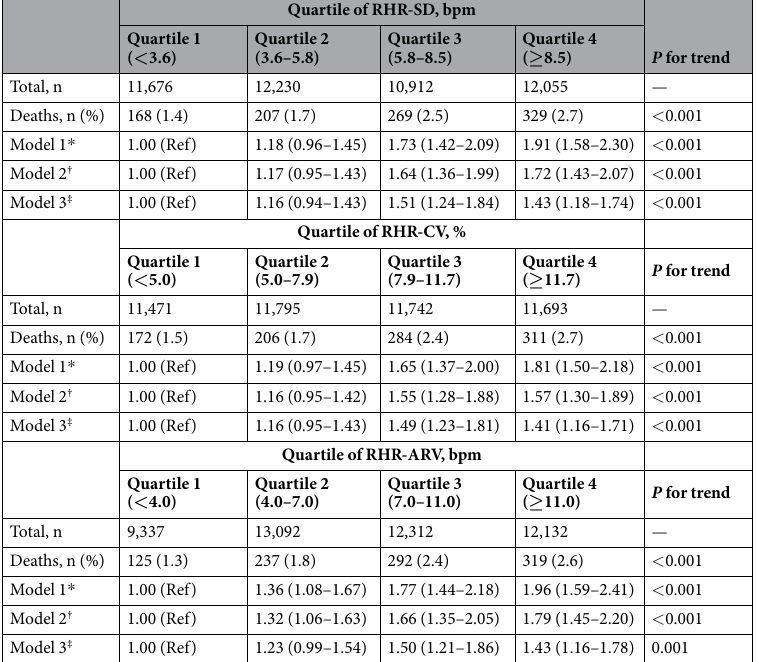
Quartile of RHR-SD, bpm